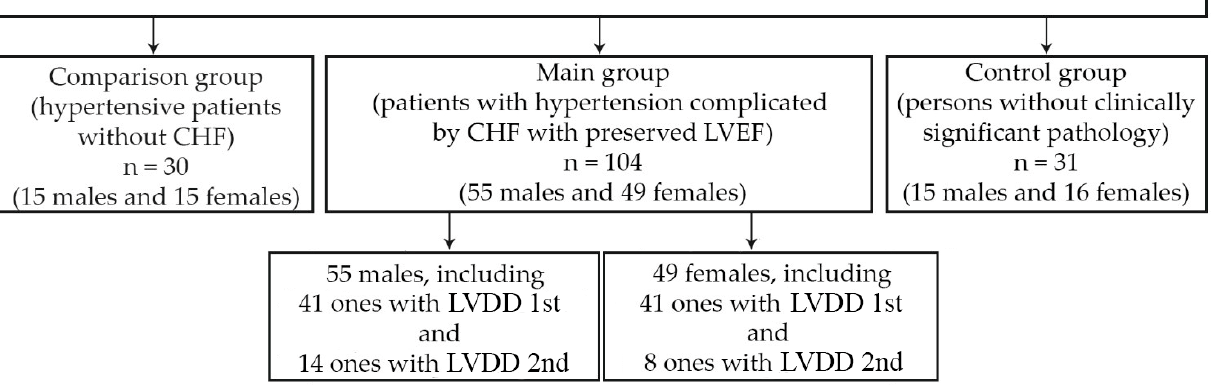
Figure 1. Scheme for the selection of the study participants in the main group (combination of es- sential arterial hypertension and heart failure with a preserved left ventricular ejection fraction).